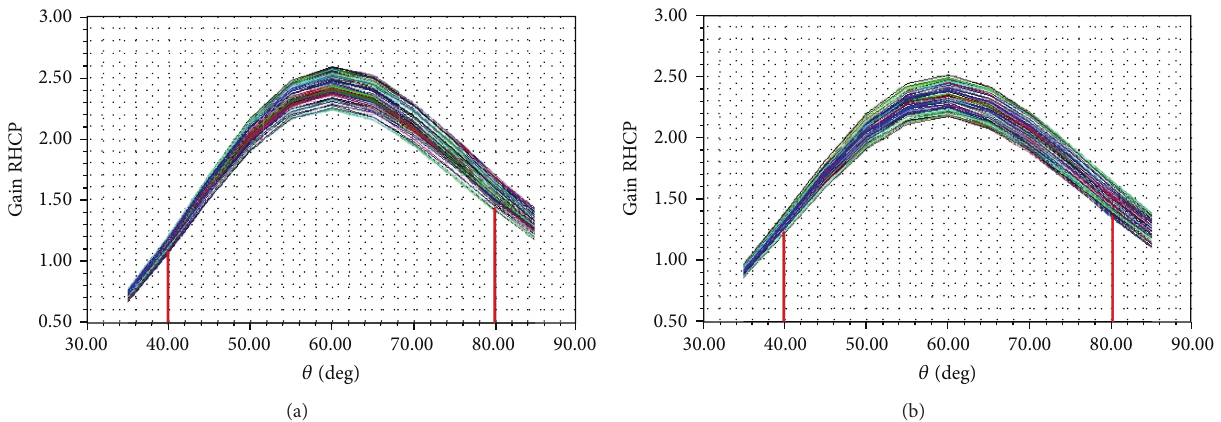
Figure 4: RHCP gain at 7209 MHz frequency: (a) for the roughly evolved antenna and (b) for the orthogonally designed one.